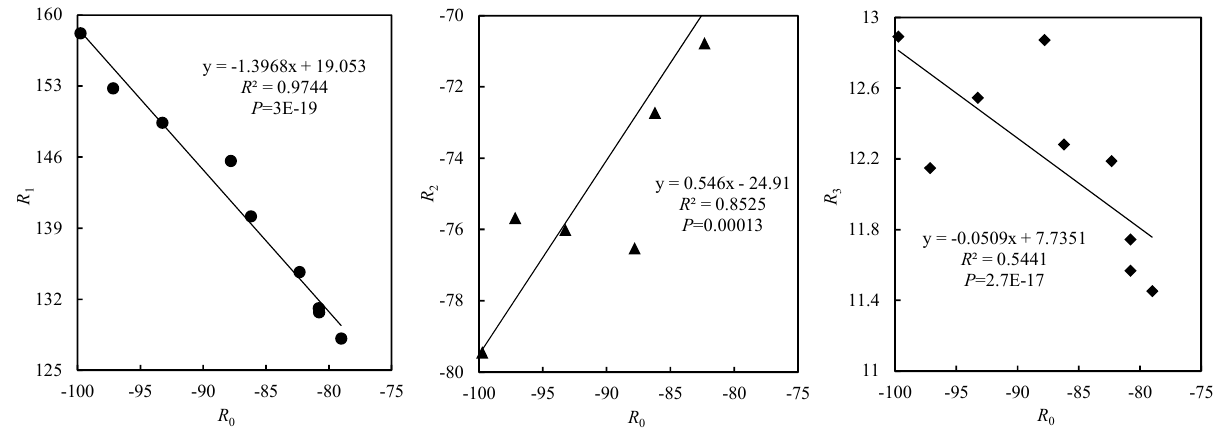
Figure 5. Relationship between parameters R 1 , R 2 , R 3 and R 0 . Relationship between parameters R 1 and R 0 , relationship between parameters R 2 and R 0 and relationship between parameters R 3 and R 0 .